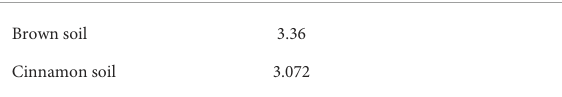
TABLE B2 Infiltration coefficient of different soils.